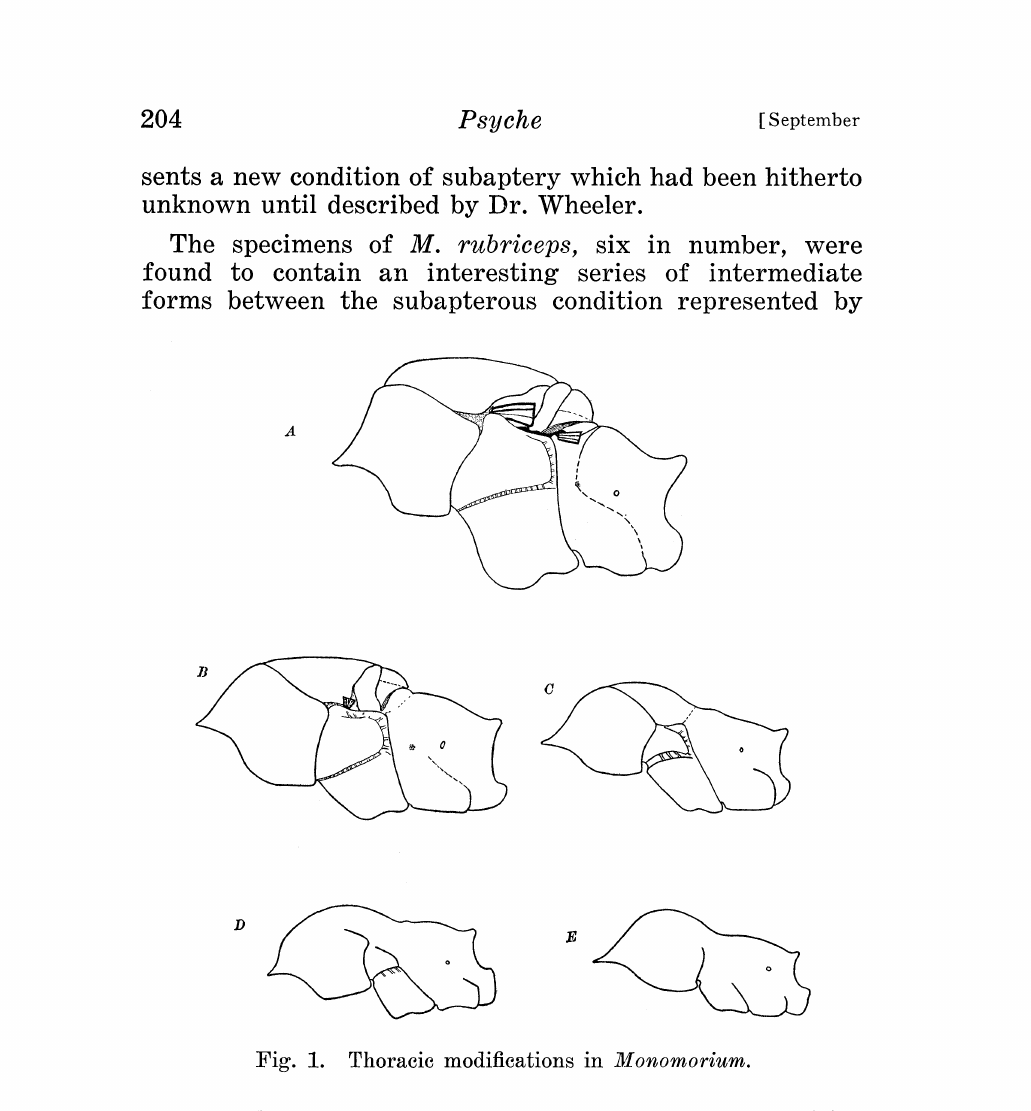
Fig. 1. Thoracic modifications in